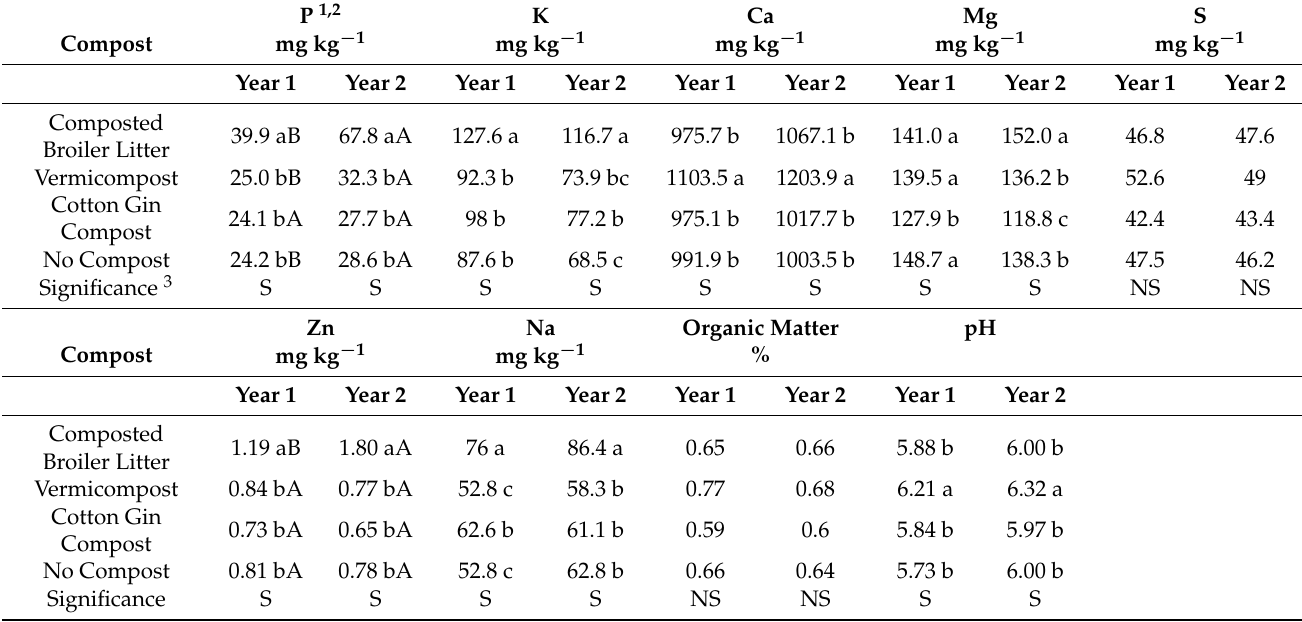
Table 5. Soil-extractable nutrient levels and soil pH in a high tunnel production of zinnia “Benary’s Giant Mix” in response to pre-plant compost treatments. Data were taken 50 days after transplanting in both